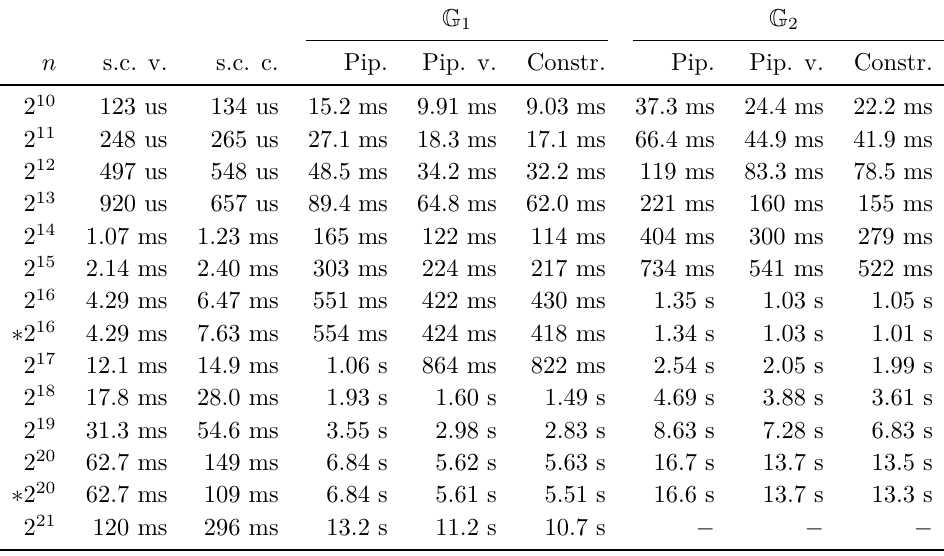
Table 4: Experimental time taken to compute S n,r by different methods